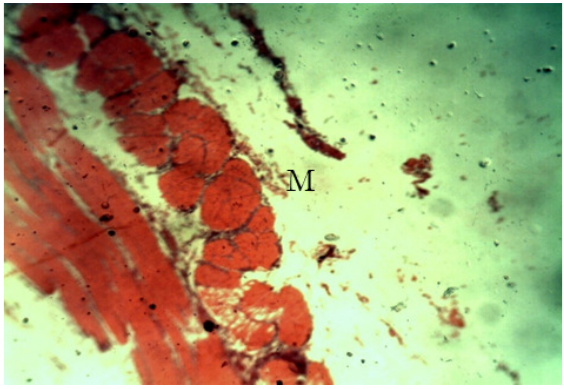
Fig. 6. Thickening of inter lobular spaces (IS) of the lungs, arrow pointing at pulmonary congestion in interlobular spaces, infiltration of mononuclear cells into inter-alveolar and interlobular spaces X 100 H&E